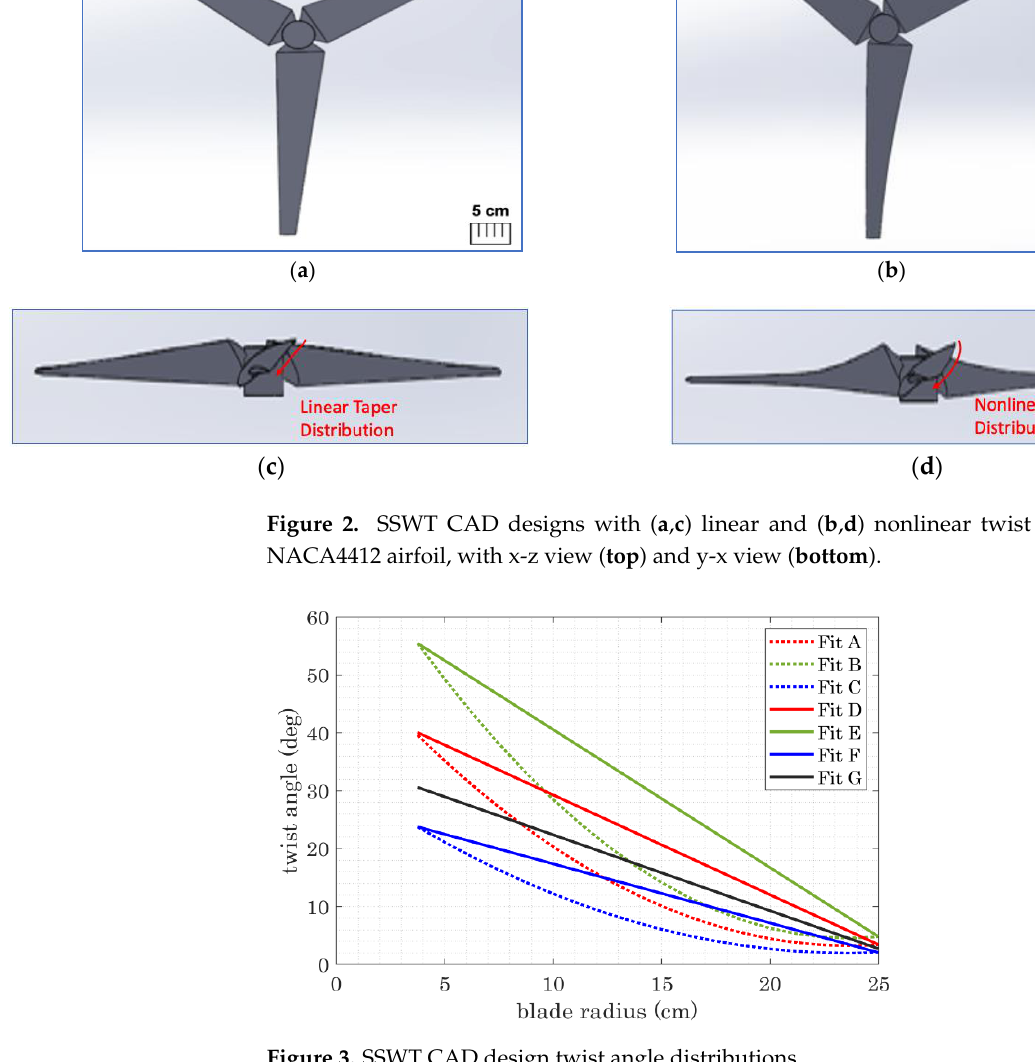
Figure 3. SSWT CAD design twist angle distributions.